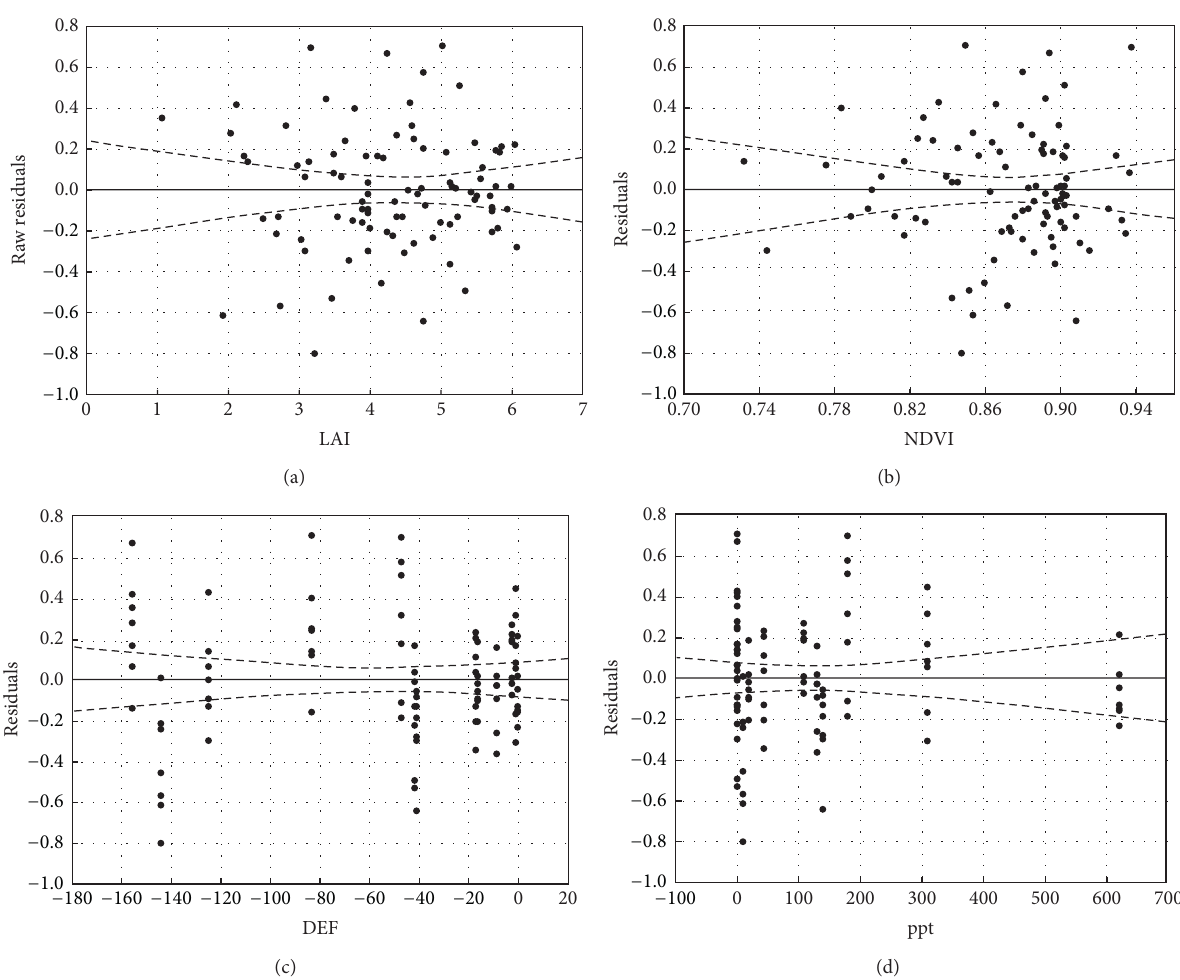
Figure 12: Scatter of the residuals with LAI, NDVI, water deficiency, and